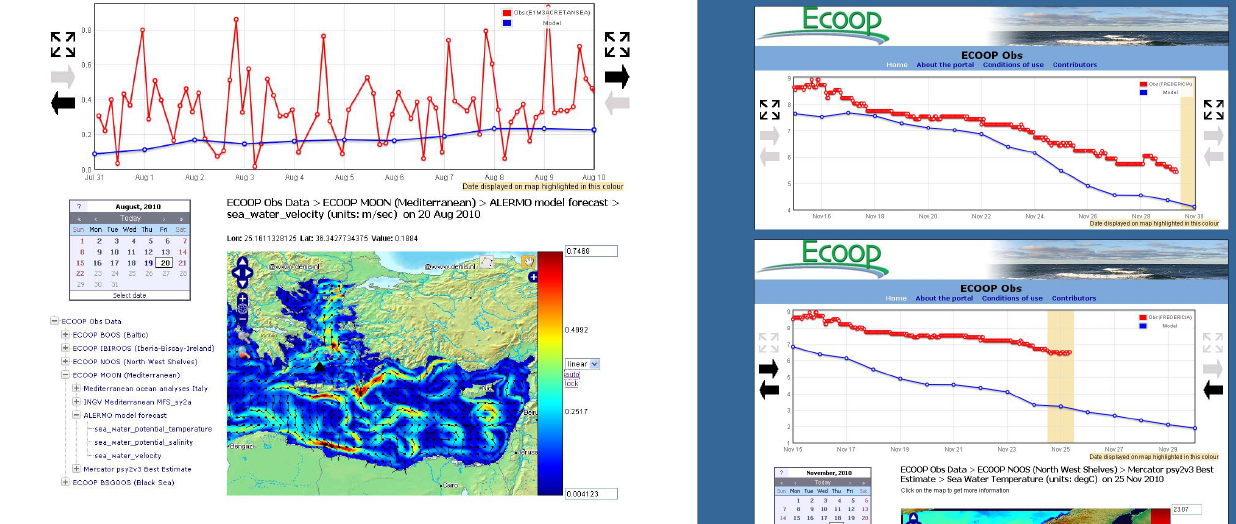
Fig. 8. Sea water velocity output from the ALERMO model from the University of Athens compared to current meter data from the E1M3ACRETANSEA in situ station (black triangle).